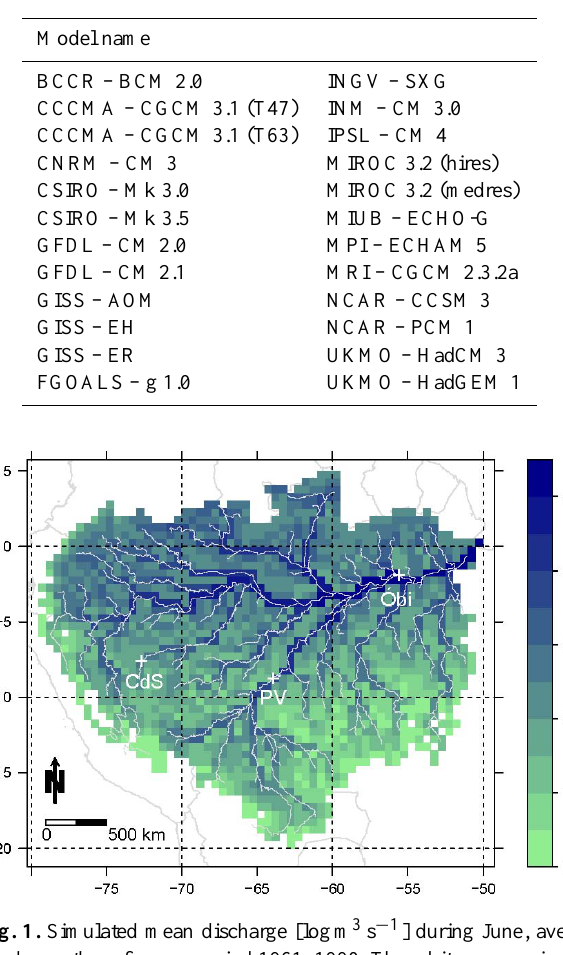
Table 4. List of the 24 IPCC coupled general circulation models (GCMs) used in this study. Details for the climate models see IPCC 2007 AR4, chapter 8 (Randall et al., 2007).